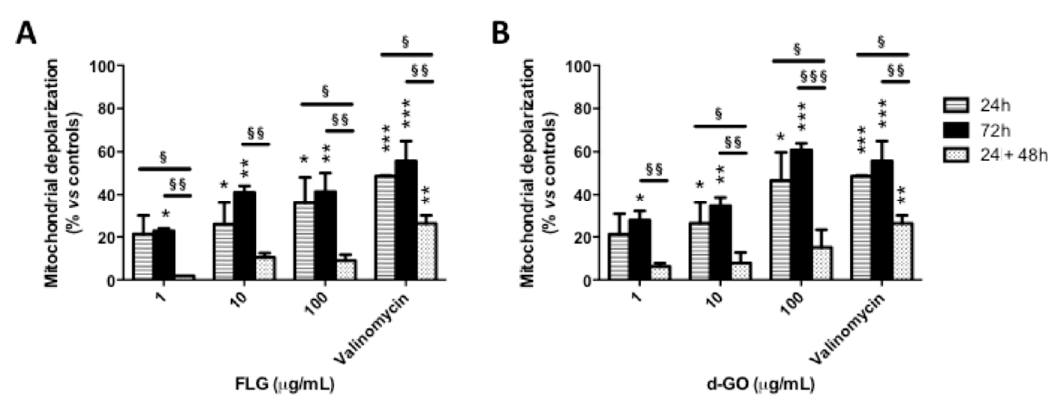
Figure 2. Effect of GBMs on mitochondrial depolarization in HaCaT cells. HaCaT cells were exposed to FLG ( A ) or d-GO ( B ) (1, 10 and 100 μ g/mL) for 24 or 72 h (continuous exposure), or for 24 h followed by 48 h recovery in GBM-free medium (recovery exposure; 24 + 48 h) before the evaluation of mitochondrial depolarization using the JC-1 potentiometric probe. As a positive control, cells were exposed to 0.1 μ g/mL valinomycin. Results are the mean ± SE of 3 independent experiments performed in triplicate. Statistical differences vs. negative controls: *, p < 0.05; **, p < 0.01; ***, p < 0.001 (One-way ANOVA and Bonferroni’s post-test). Statistical differences between continuative and recovery conditions: § , p < 0.05; §§ , p < 0.01; §§§ , p < 0.001 (Two-way ANOVA and Bonferroni’s post-test).